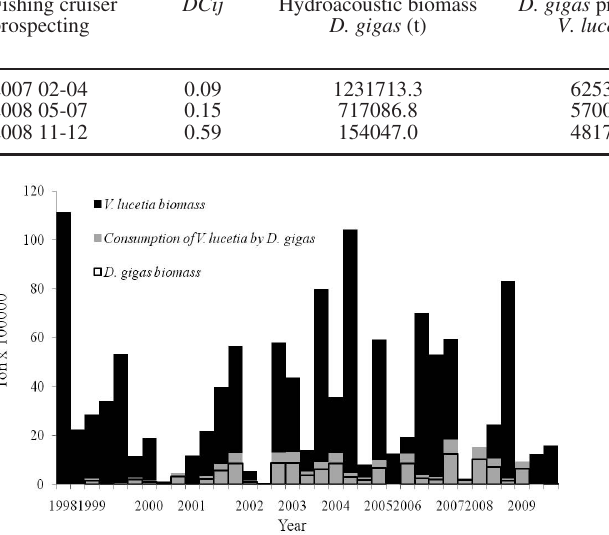
Fig . 4. – Acoustic biomass estimates of D. gigas and V. lucetia in the Humboldt Current System off Peru, and estimates of jumbo squid consumption on V. lucetia